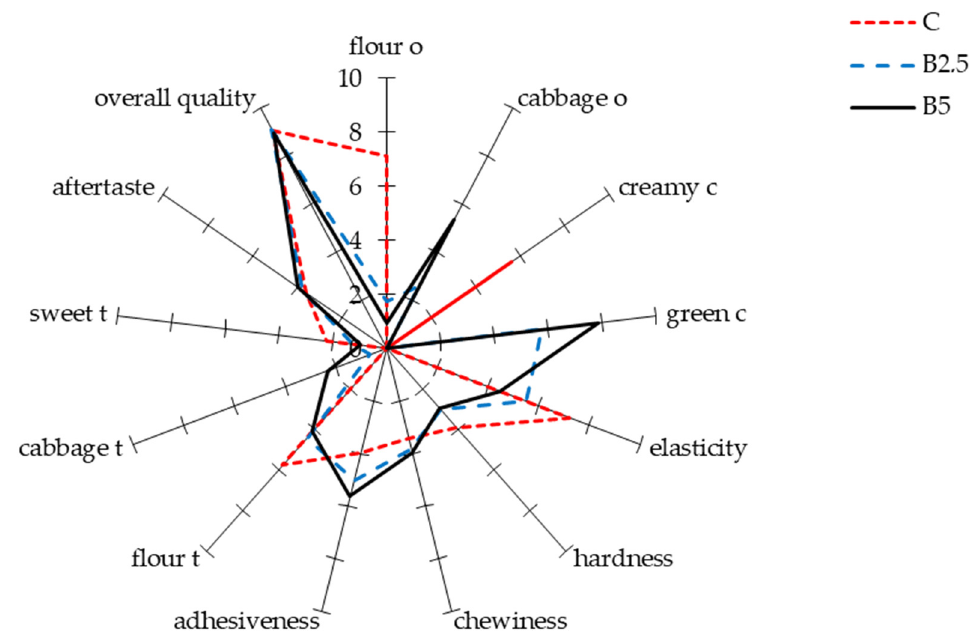
Figure 2. QDA sensory analysis and PCA biplot of experimental pasta fortified with BLP. C: control pasta; B2.5: pasta fortified with 2.5% broccoli leaf powder; B5: pasta fortified with 5% broccoli leaf powder; o: odour; c: colour; t: taste.